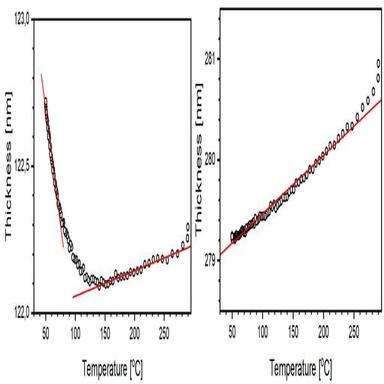
Changes of thickness occurring during free cooling of a) TEOS_sw, b) TEOS_BTSE_sw annealed for 20 min at 290◦C. The slope of the linear fit between 250◦C and 150◦C corresponds to the thermal expansion coefficient.